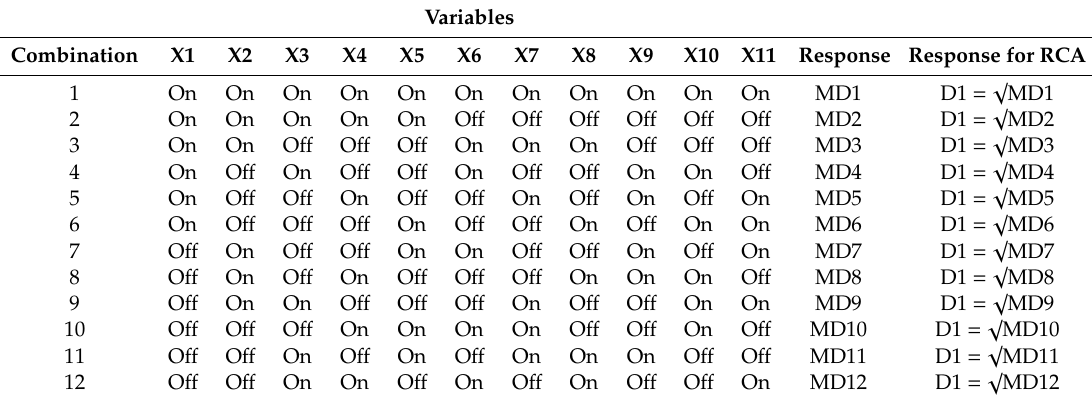
Table 1. Physical layout of corresponding L 12 (2 11 ) orthogonal array with 11